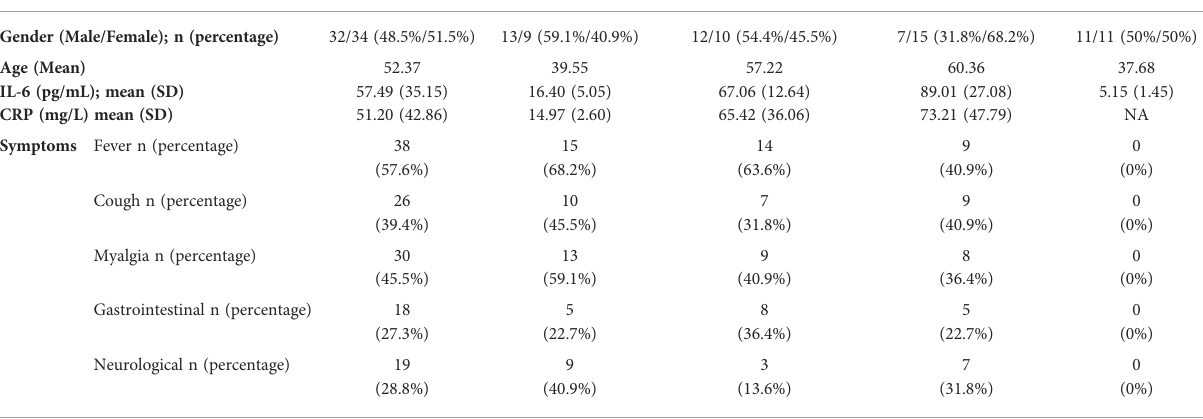
TABLE 2 Patient ’ s clinical